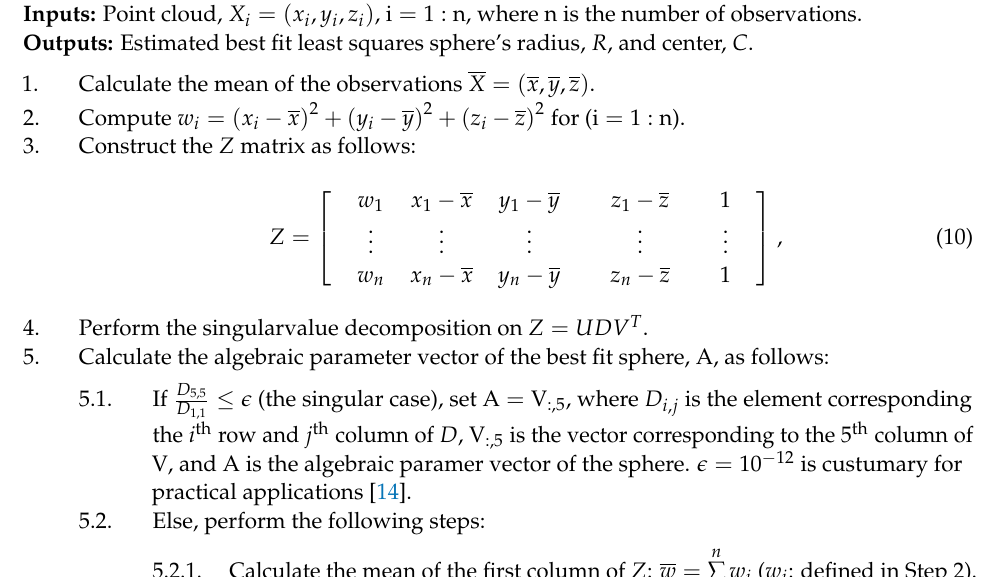
Algorithm 2 Hyperaccurate Direct Algebraic Sphere